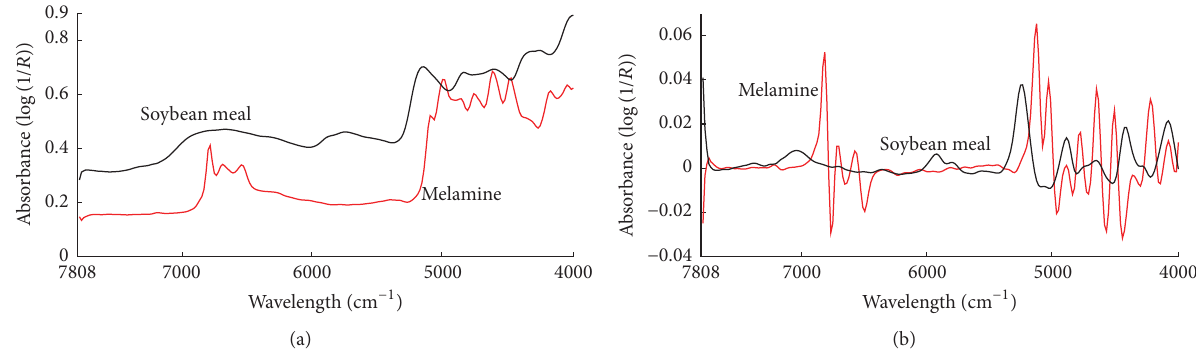
Figure 2: Average spectrum of soybean meal and melamine particles: raw spectra (a) and first derivative spectra (b).